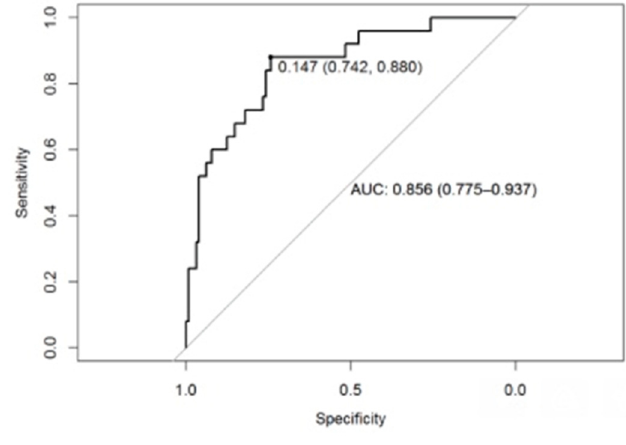
Figure 4. Results of the receiver operating characteristic (ROC curve). Table 5. Variable importance to diagnose handwriting